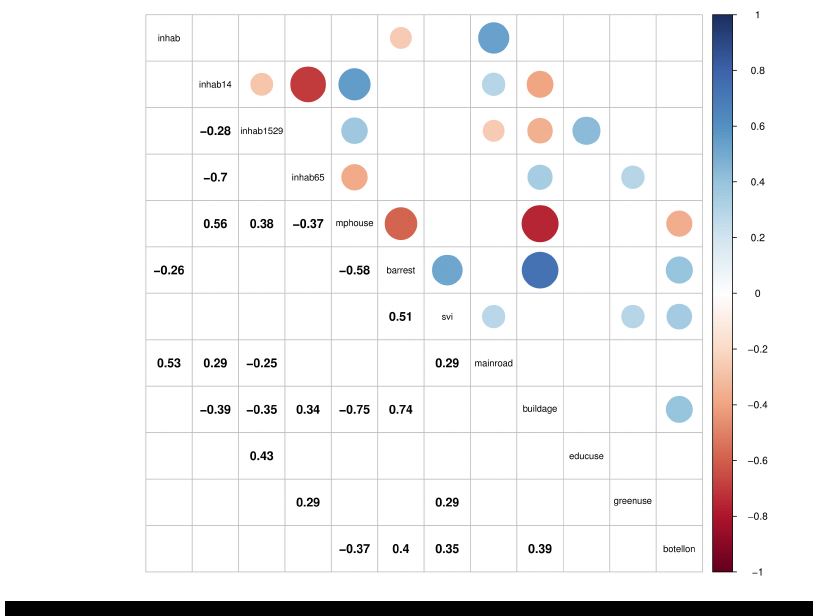
Figure 3. Correlation matrix for the variables representing borough characteristics. Only the correlation coefficients that are significant at the 0.05 level are shown. Figure generated with the R package corrplot